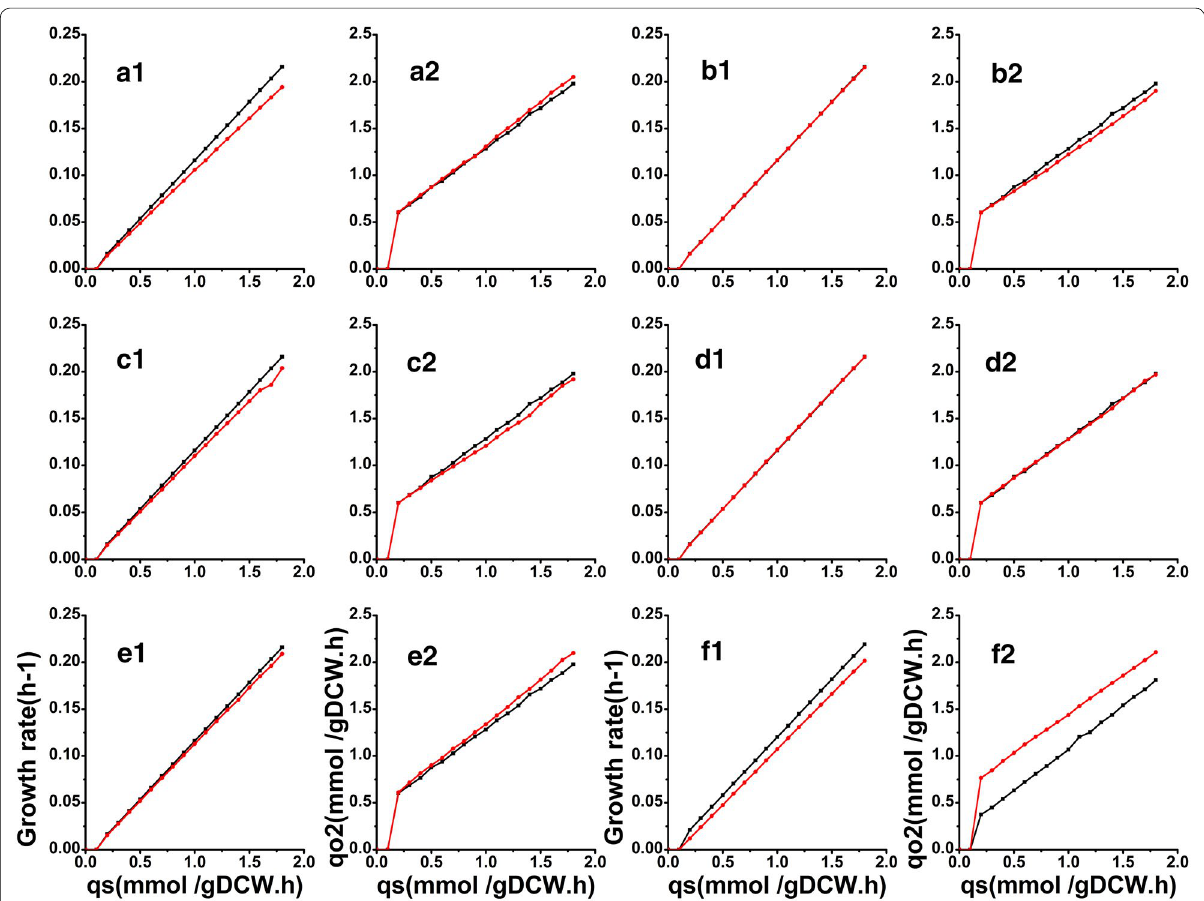
Fig. 3 Effects of each parameter change on specific growth rate and specific oxygen uptake rate for sensitivity analysis with iRY1243. The simula- tions were performed by varying the lipid content (6.2–16.2%) ( a1 , a2 ), protein content (37–47%) ( b1 , b2 ), RNA content (6.6–16.6%) ( c1 , c2 ), DNA content (0.1–1%) ( d1 , d2 ), carbohydrate content (26.9–36.9%) ( e1 , e2 ), and the NGAN (1.26–3.78 mmol ATP/gDCW h) ( f1 , f2 ). Red represents the simulated results for the maximum values of the input parameters, and black represents the lower content in all